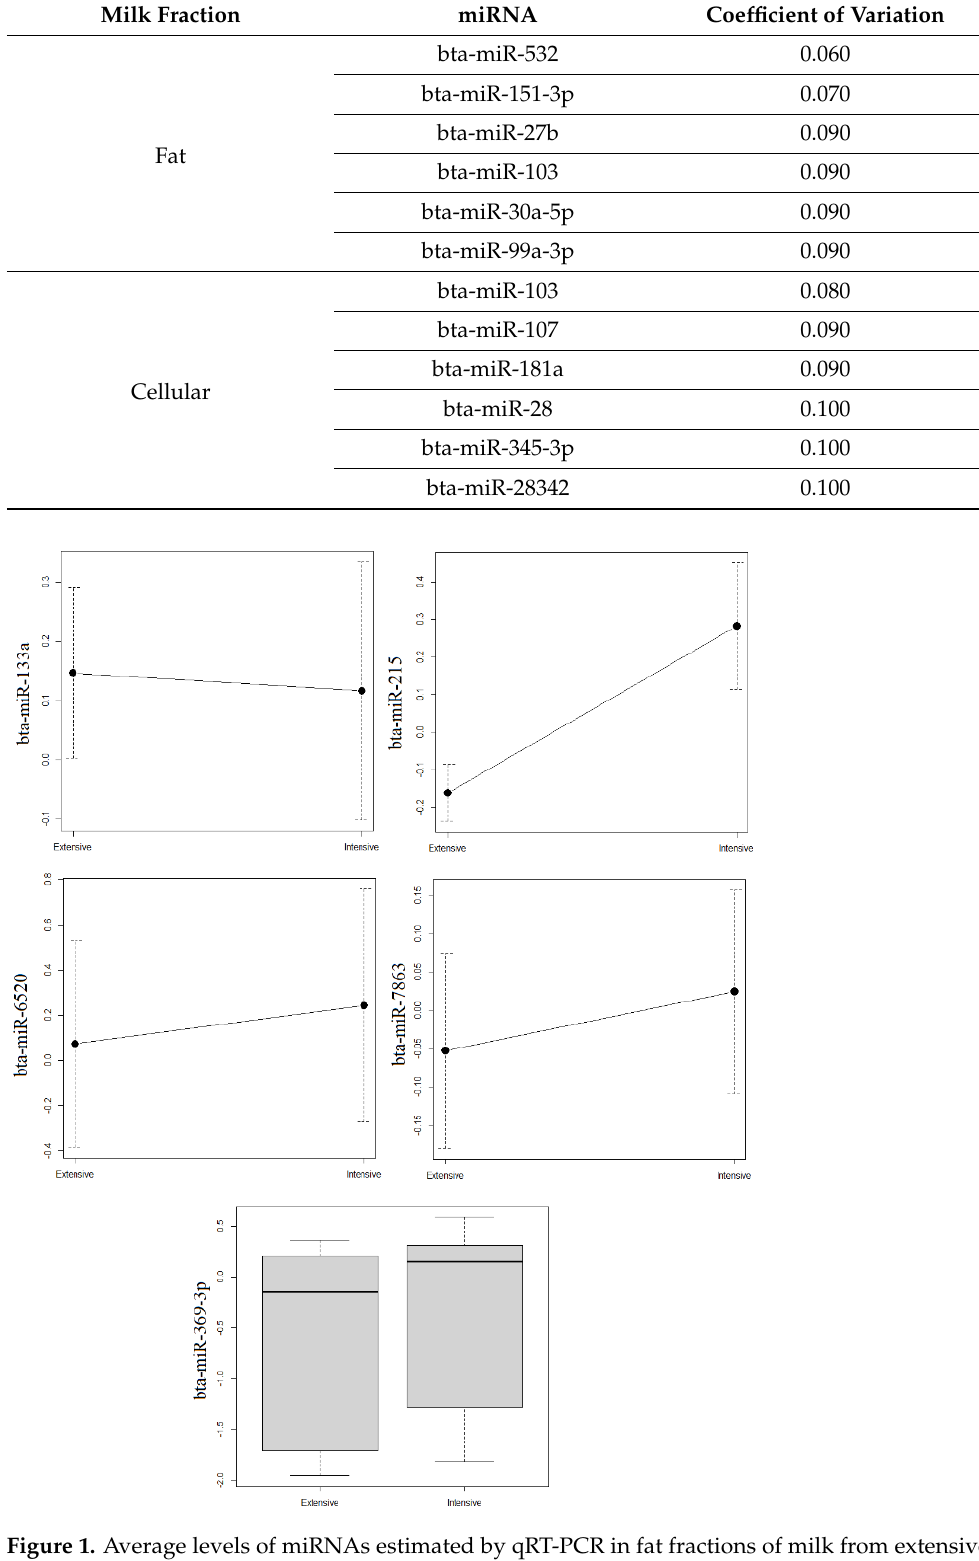
Figure 1. Average levels of miRNAs estimated by qRT-PCR in fat fractions of milk from extensive and intensive farms. On the X axis, production systems are represented; on the Y axis, average levels of each miRNA are represented. Levels of bta-miR-369-3p showed a skewed distribution, so they are shown using a box-and-whisker plot. The errors bars in the other plots indicate standard deviation.